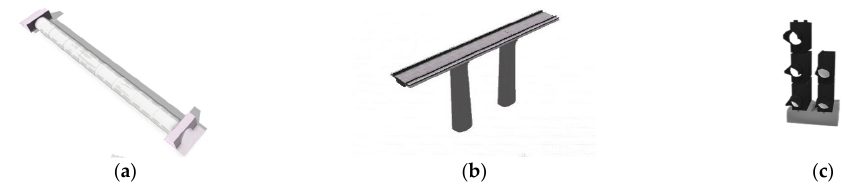
Figure 7. Three-dimensional symbol modelling: ( a ) bridge model; ( b ) tunnel model; ( c ) signal machine model.